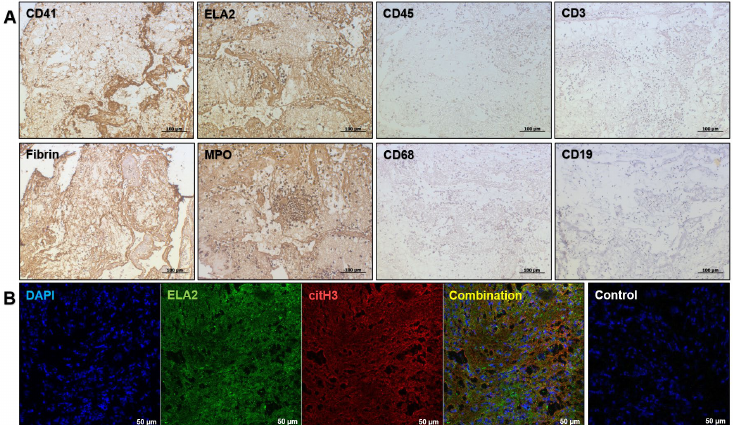
Figure 3. Neutrophil invasion and abundant NETs indicate immunothrombosis of BHV. ( A ) Immunohistochemical staining of the prosthetic thrombus identified platelets (CD41-positive staining), fibrin, and neutrophils (ELA2- and MPO -positive staining). CD45 staining was inconsistent. Macrophages (CD68), T cells (CD3) and B cells (CD19) were not detected. Magnification ×200. Scale bar = 100 µm; ( B ) Immunofluorescence staining showed the co- localization of citrullinated histone H3 with neutrophil elastase (ELA2) and nuclear dye (4′,6 - diamidino-2-phenylindole, DAPI) within the thrombus indicating the formation of NETs. Sections without the primary antibody staining but still counterstained with DAPI were used as a negative control. Magnification ×200. Scale bar = 50 µm. Similar to the bioprosthetic clot, the immunohistochemical and immunofluorescence profiling confirmed the aggressive neutrophil infiltration (Figure 4A) and the presence of NETs (Figure 4B) in the left atrial thrombus.